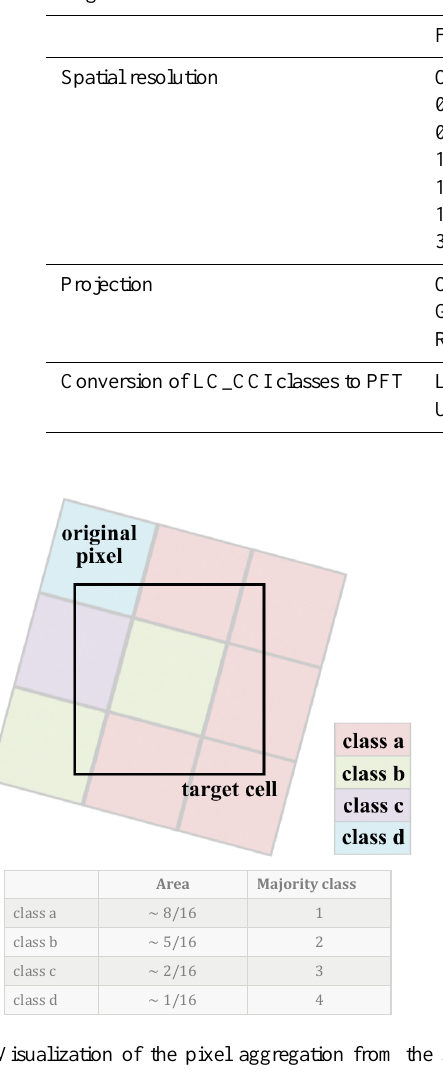
Figure 1. Visualization of the pixel aggregation from the spatial resolution of original LC_CCI map product into the user-defined spatial resolution of the aggregated LC_CCI map